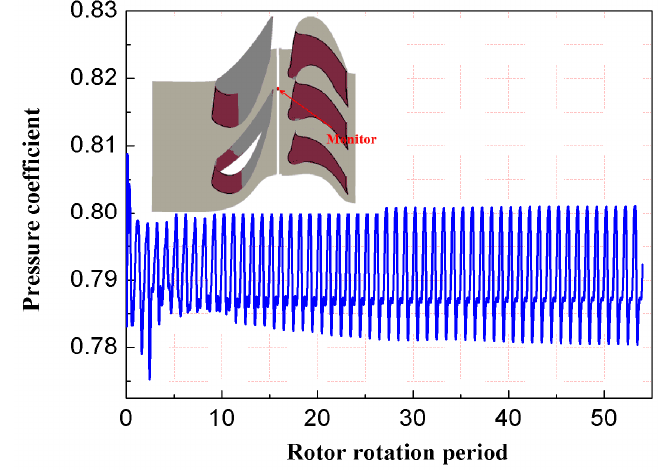
Figure 3. Pressure coefficient change at the monitoring point.